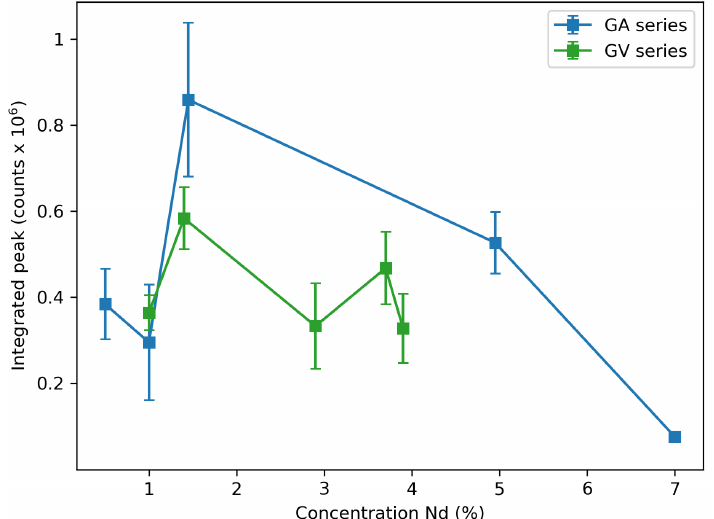
Figure 13. Integrated peak intensity from 1050 nm to 1100 nm corrected for the background for the GA series and the GV series. Concentrations are those obtained by EDX measurements except for the 0.5% and both 1% samples. Measured intensities are the average of three measurements on different samples, and the error bars reflect the resulting standard